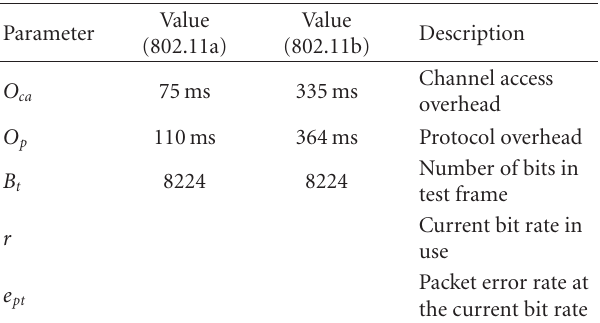
Table 1: Airtime cost constants.